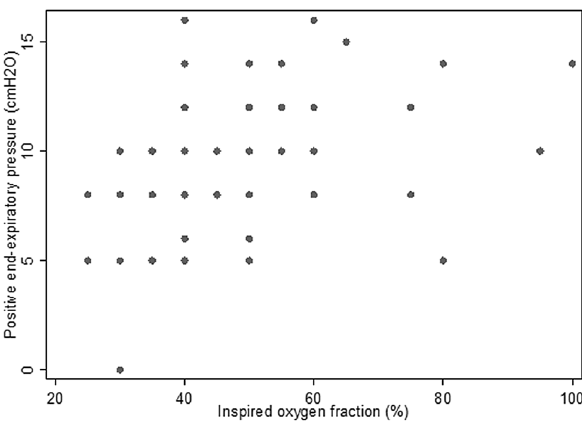
Figure 1. Distribution of PEEP and FIO2 among patients with ARDS.